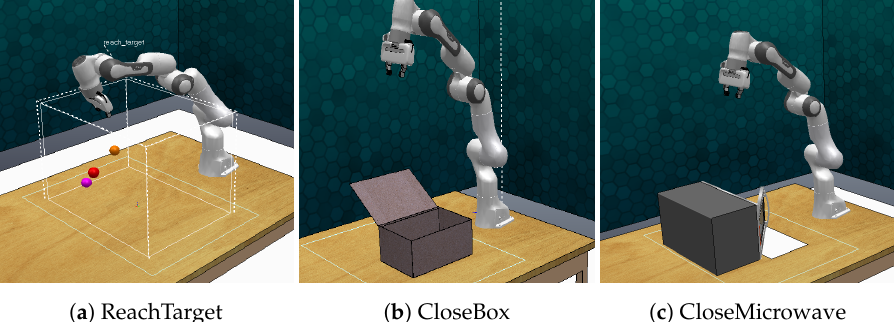
Figure 3. Franka Emilka Panda Robotic Arm with 7 Dof displayed in RLBench simulator. ( a ) ReachTar- get with red ball as the target object. ( b ) CloseBox and ( c ) CloseMicrowave tasks.